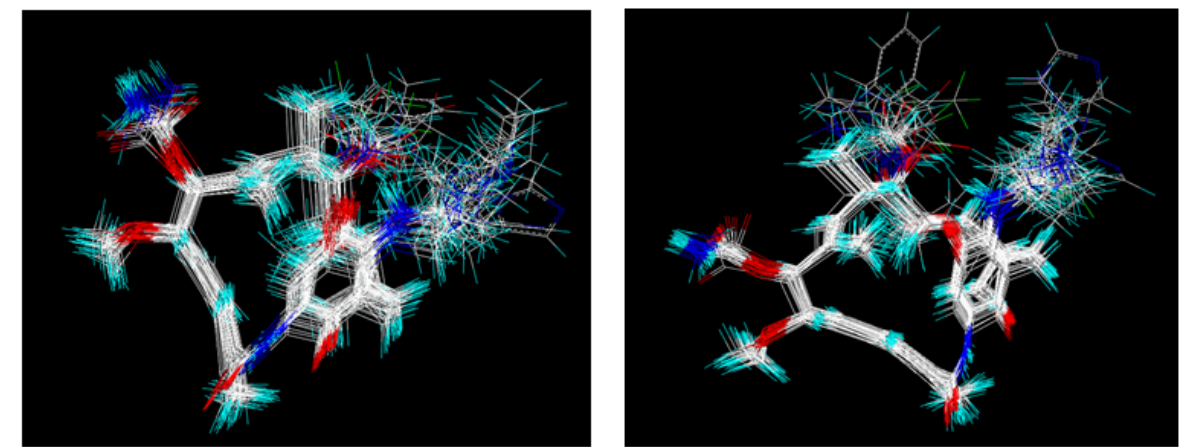
Figure 5. Alignment used for models 3DQSAR B and C, respectively.